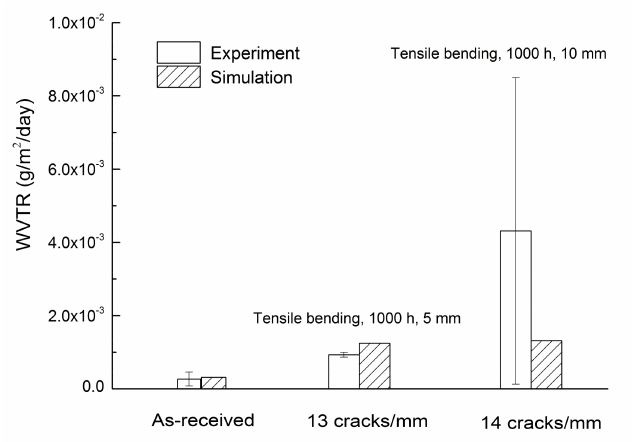
Figure 14. Comparison of numerical and experimental results of WVTR value for the intact and damaged barrier thin